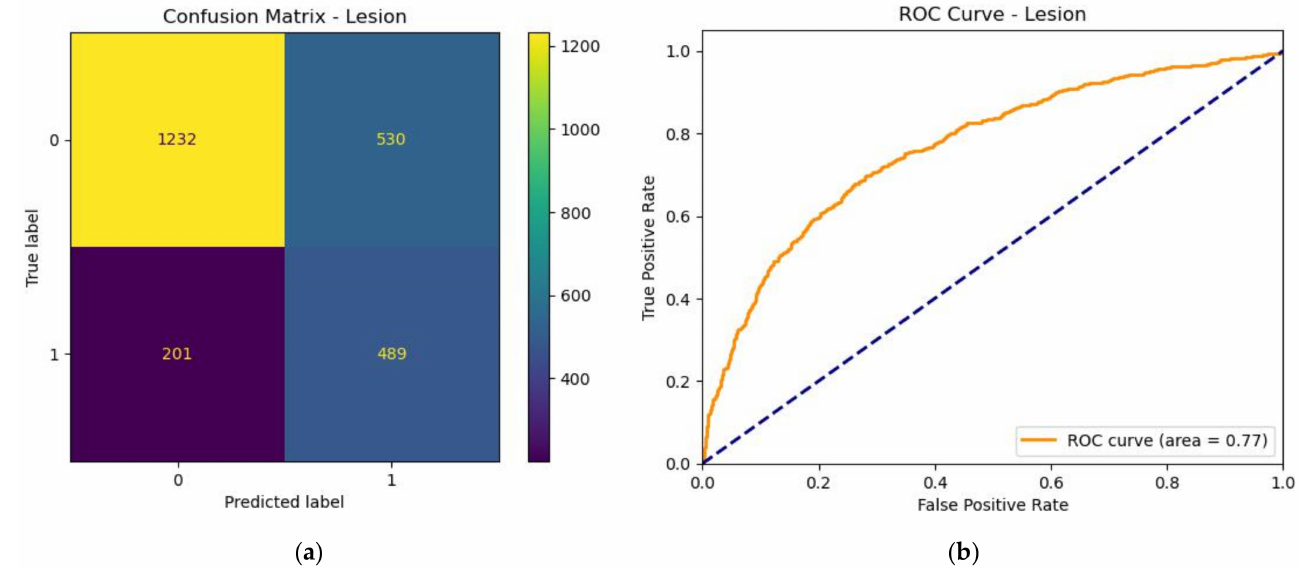
Figure 7. Model quality—Lung Lesions. ( a ) Confusion matrix. ( b ) ROC